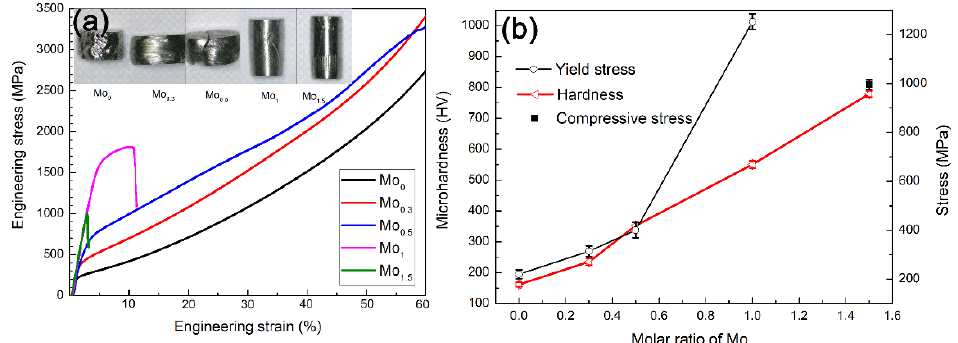
Figure 6. ( a ) Compressive engineering stress-strain curves of Mo x high entropy alloys, in which the photos of the cylindrical samples of Mo x HEAs after compression tests were inset, and ( b ) Vickers hardness, yield and compressive stress obtained from ( a ).